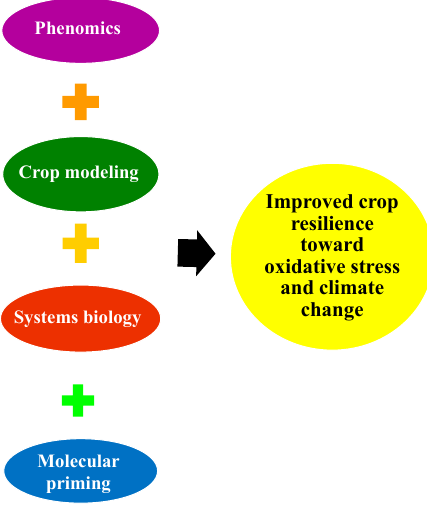
Figure 8. Integration of systems biology, phenomics, crop modeling, and molecular priming as a holistic approach for the development of climate-smart crops to improve growth and productivity.